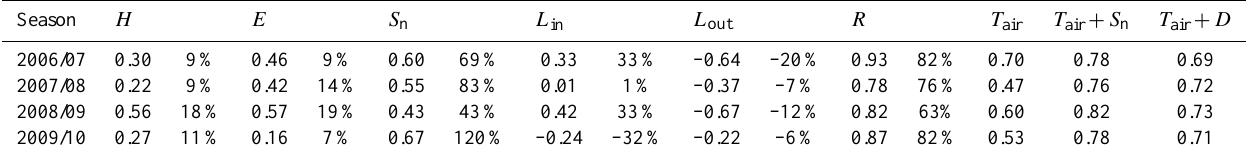
Table 4. Correlation coefficient ( r) , and corresponding ρ to A , for daily mean energy fluxes, T air and combinations of T air , S n , and D .